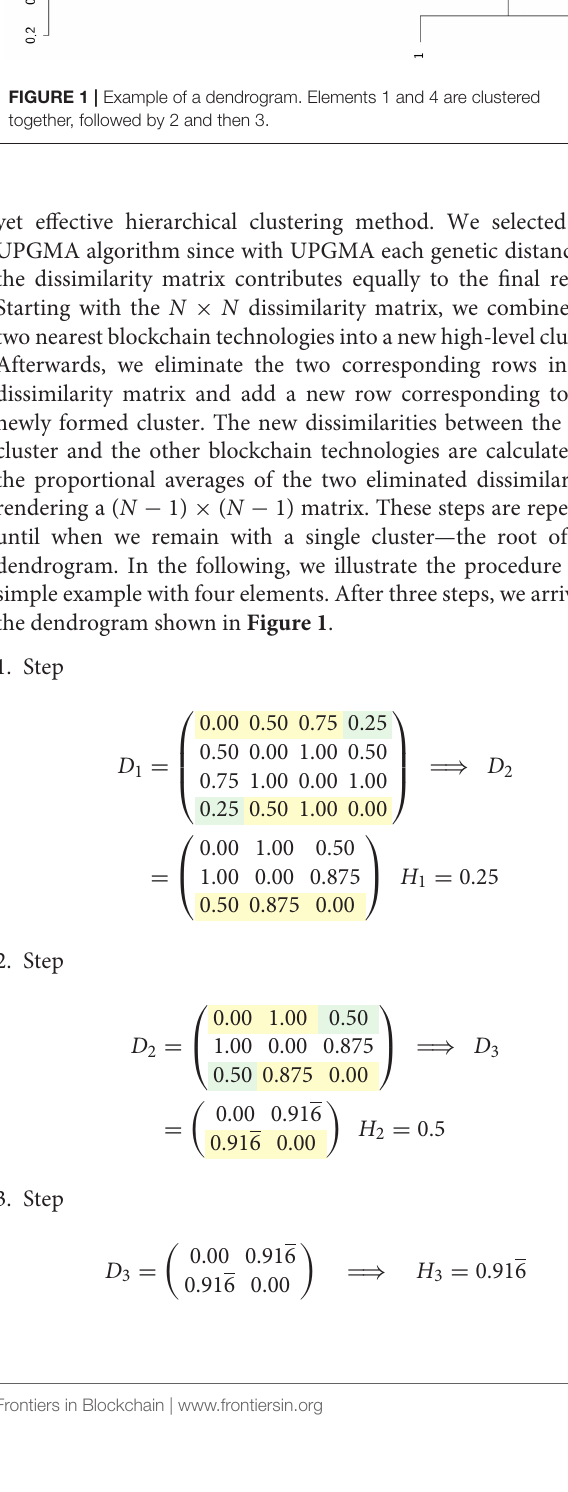
FIGURE 1 | Example of a dendrogram. Elements 1 and 4 are clustered together, followed by 2 and then 3.